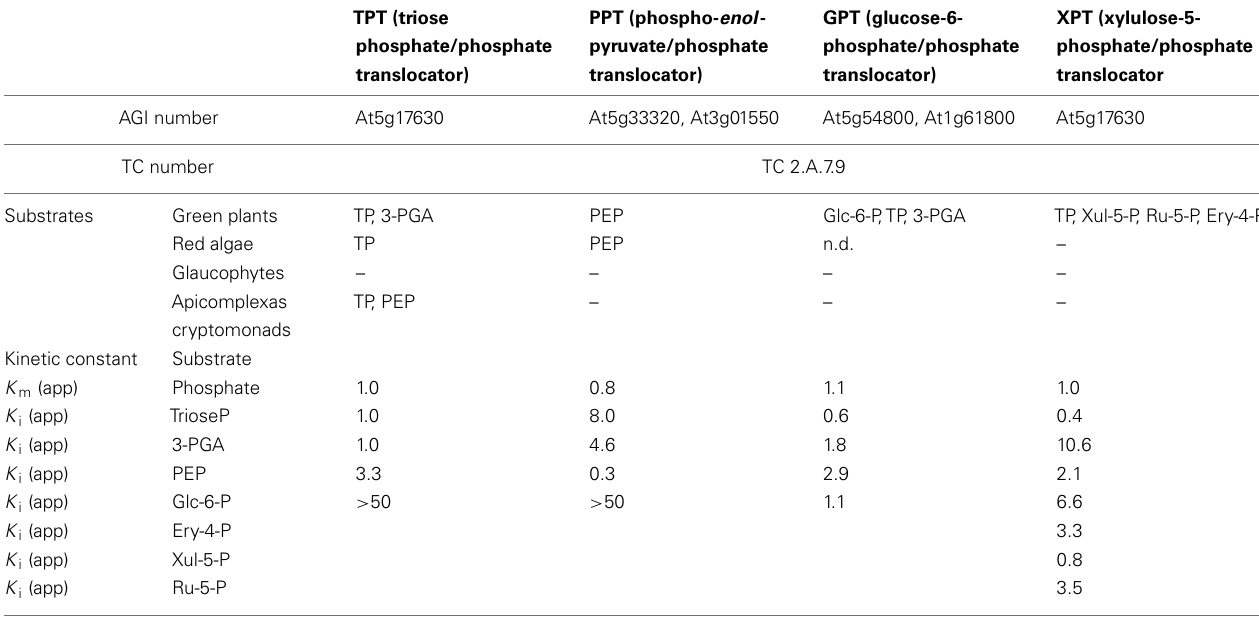
Table 1 | Phosphate translocators of the plastidic inner envelope